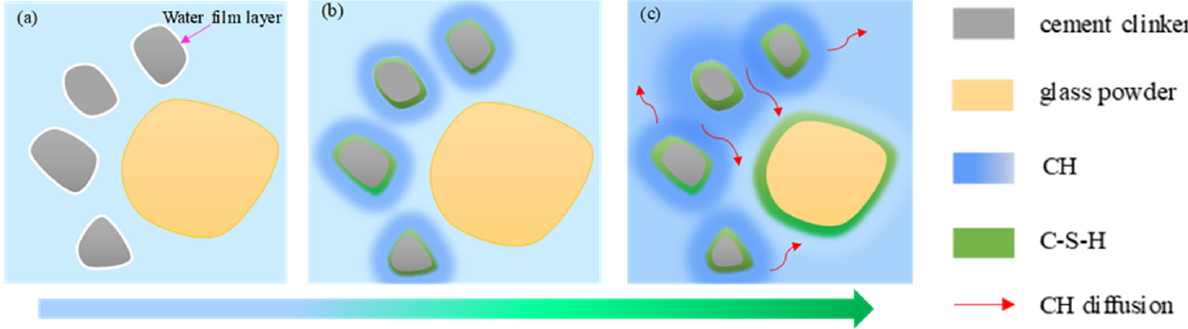
Figure 1. Evolution of glass powder-cement hydration process ( a ) initial mixing ( b ) cement hydration ( c ) pozzolanic reaction of glass powder.